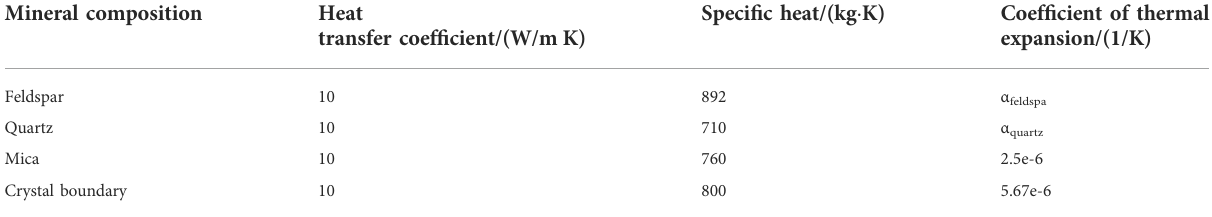
TABLE 4 Temperature meso parameters.